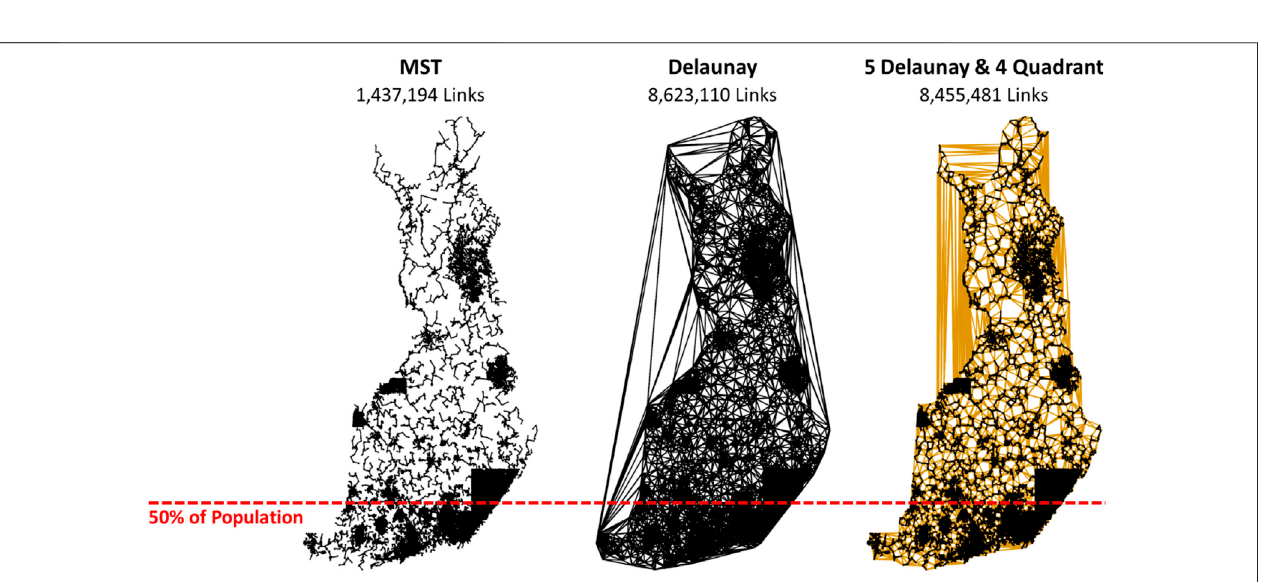
Frontiers in Robotics and AI |